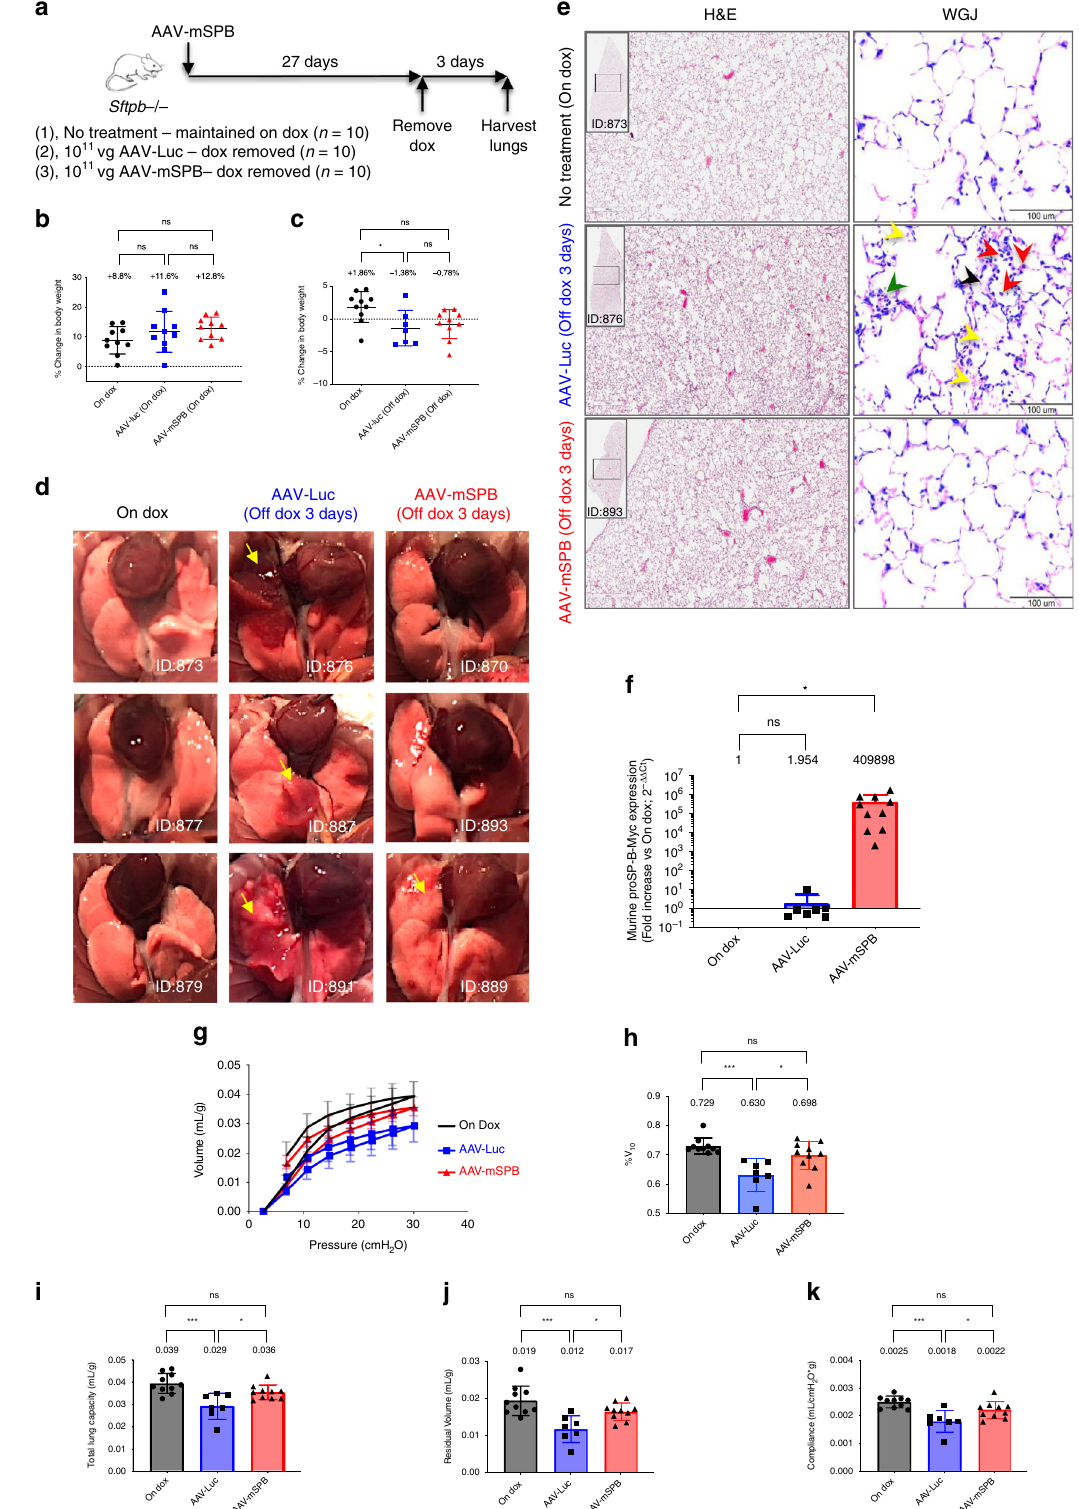
signs of alveolar damage in AAV-hSPB treated mice (Fig. 7f, Supplementary Fig. 9d). To demonstrate that lung injury was not caused by post-mortem decomposition, healthy mice on dox euthanized 24 h before lung collection did not exhibit comparable levels of damage as the 1 × PBS treated negative control mice (Supplementary Fig. 9e, f). IF images demonstrated